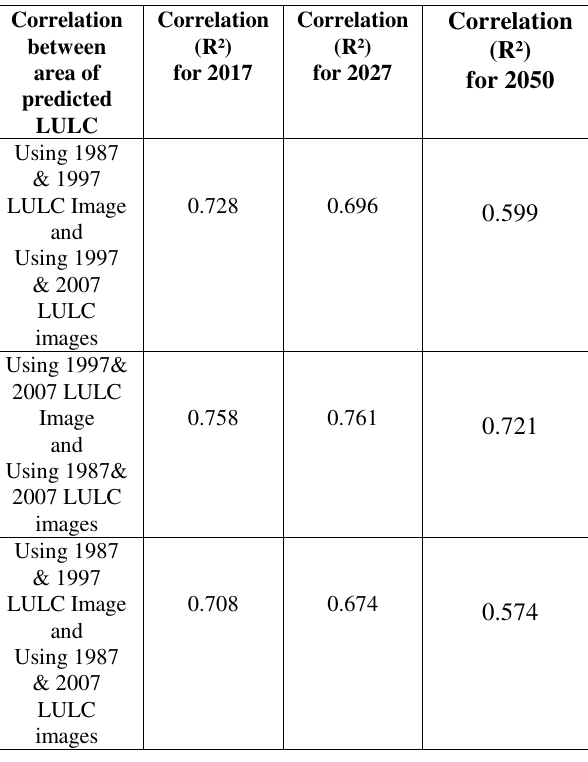
Table 6. Correlations of between location of predicted LULC using 1987 & 1997 LULC image, location of predicted LULC using 1997 & 2007 LULC image and location of predicted LULC using 1987 & 2007 LULC image 4.